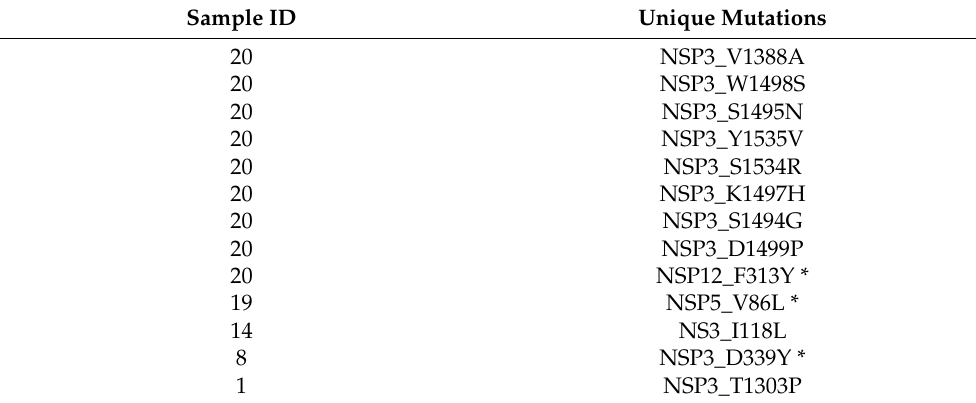
Table 4. Unique mutations in NSP and NS3 SARS-CoV-2 isolates from Punjab province, Pakistan.